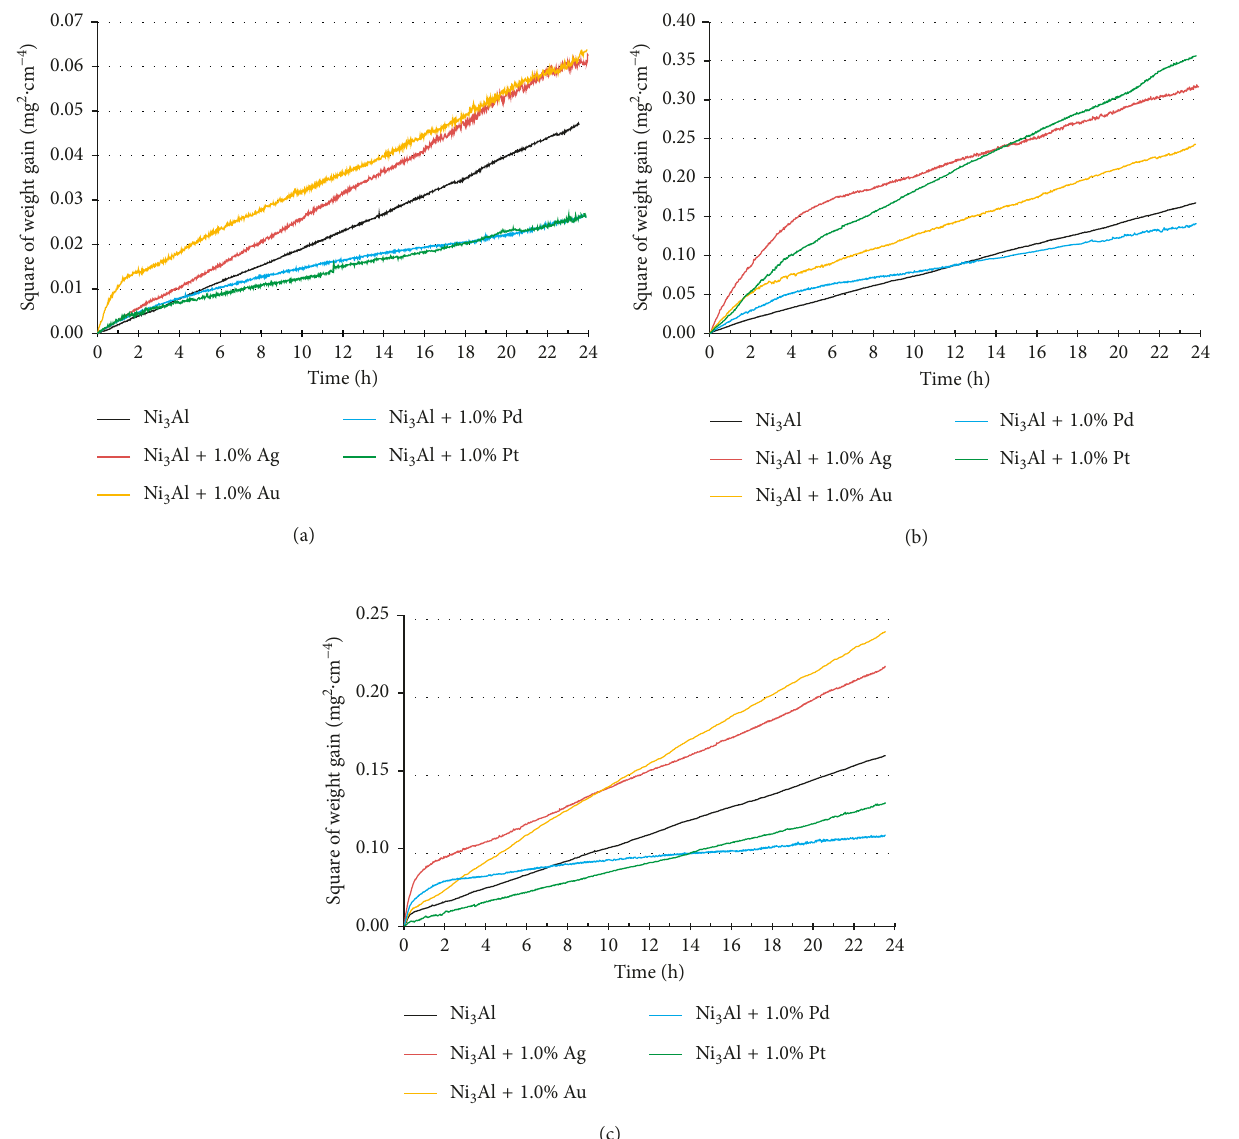
Figure 5: Square weight gain versus time of exposure of intermetallic alloys oxidized in O